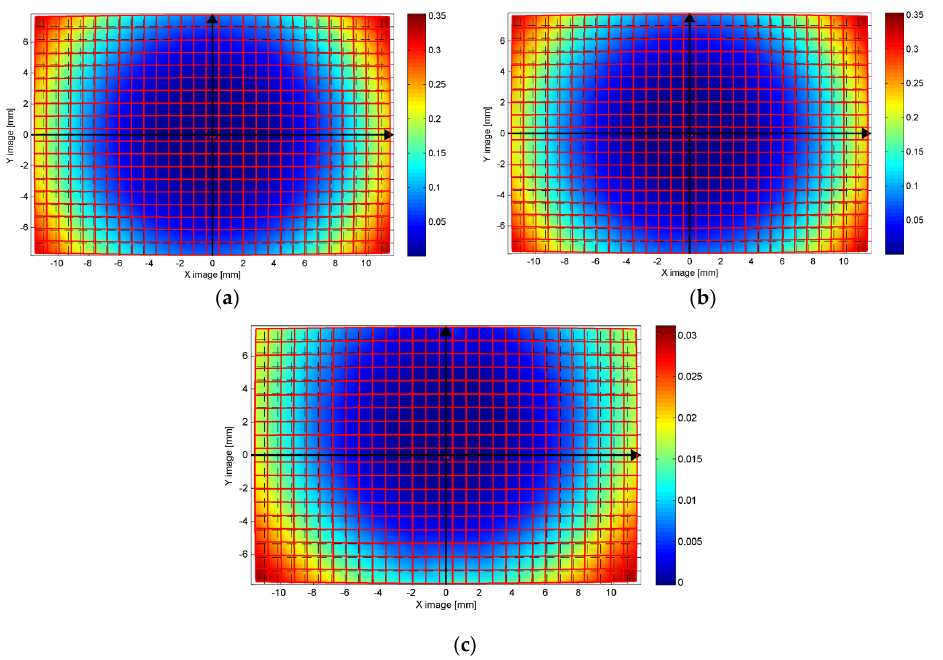
Figure 15. Distortion maps (difference in mm between ideal and actual distorted pixel position): ( a ) in air, ( b ) in water; and ( c ) difference air-water.